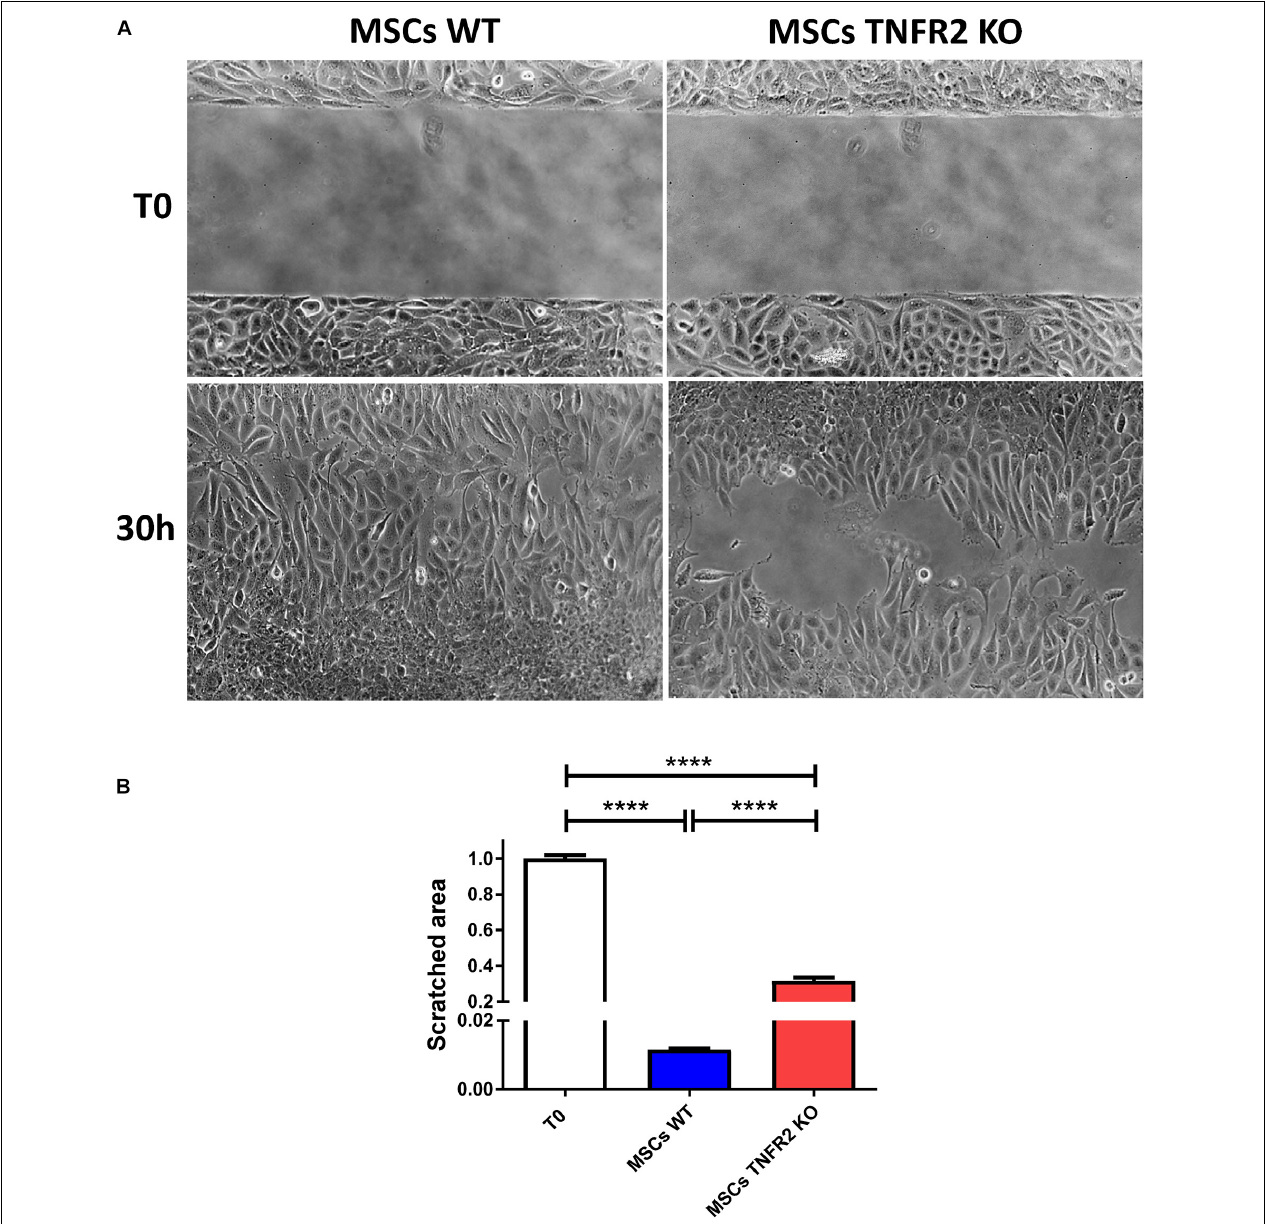
FIGURE 6 | The TNFR2 expression by mesenchymal stem cells (MSCs) is associated with their appropriate wound healing property. The ability of wild-type (WT) and TNFR2 knockout (KO)-MSCs (P2 and P3) to close a scratch in the monolayer cell surface was measured. (A) Pictures were taken every 2 h, using objectives 4 × and 10 × of the microscope in phase-contrast mode to capture the wound area filling. (B) The size of the scratched area was measured in order to evaluate the wound area decrease. Results are collected from three independent experiments ( n = 6). T0, time 0; and 30 h, 30